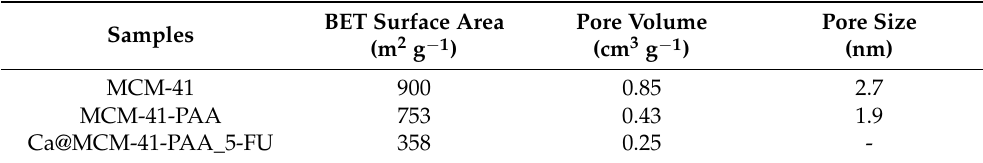
Table 1. BET surface area, pore volume, and pore size of MCM-41, MCM-41-PAA and Ca@MCM-41-